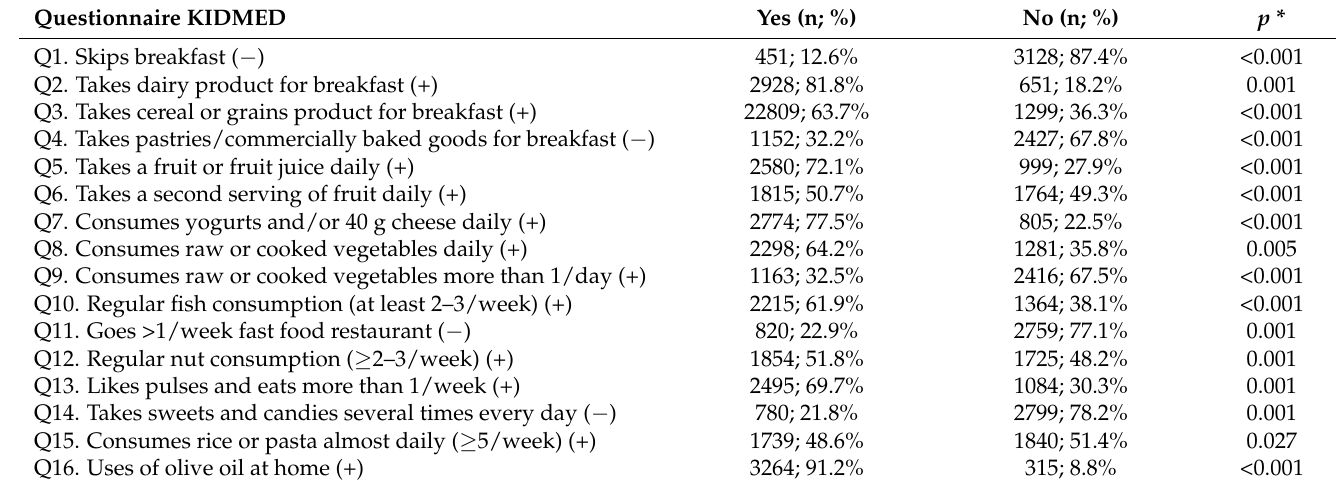
Table 2. Proportion of children that answered ‘yes’ or ‘no’ to each question of the KIDMED scale.